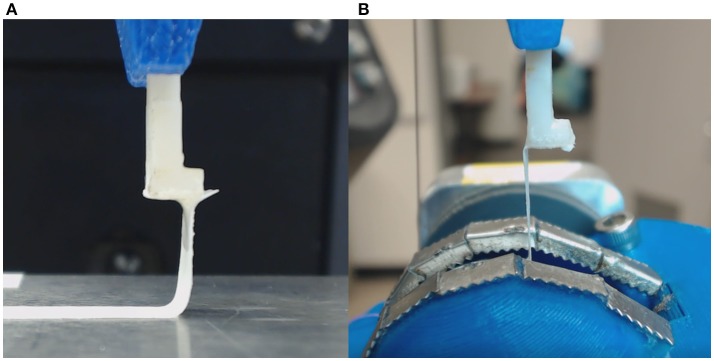
(A) Tape linear peel tests were performed and compared to (B) tape rotational peel tests to ensure validity of the custom rotational peel device.